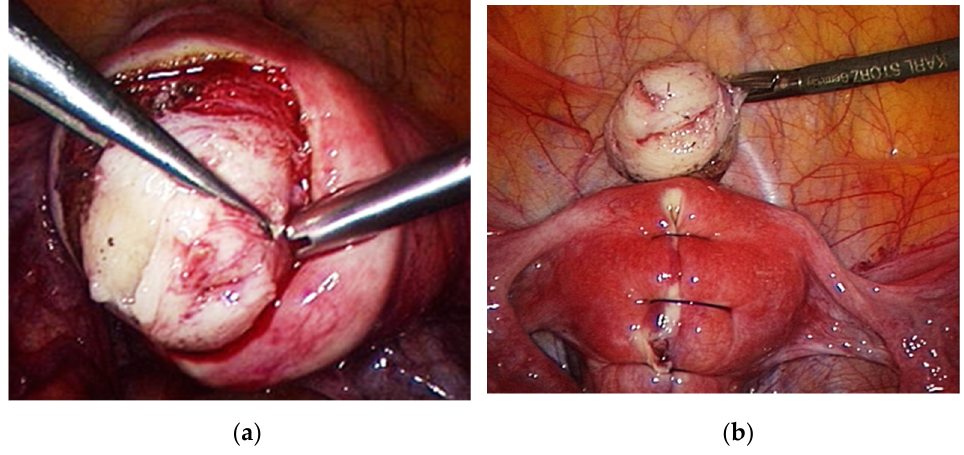
Figure 6. ( a ) laparoscopic enucleation of a fibroid with ( b ) reconstruction of the uterine